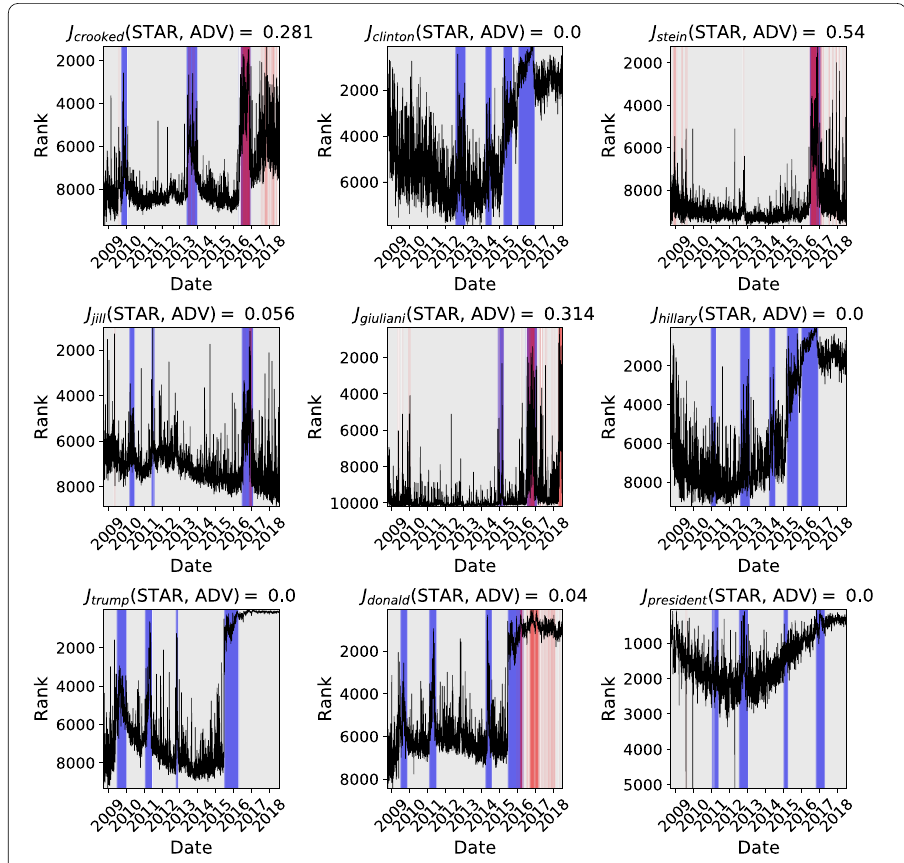
Figure 9 Comparison of STAR and Twitter’s Anomaly Detection Vector (ADV) algorithm used for detecting phenomena in Twitter 1gram time series. The Jaccard similarity coefficient is presented for each 1-gram and the region where events on detected are shaded for the respective algorithm. Blue-shaded windows correspond with STAR windows of shock-like behavior, while red-shaded windows correspond with ADV windows of anomalous behavior (and hence purple windows correspond to overlap between the two). In general, ADV is most effective at detecting brief spikes or strong shock-like signals, whereas STAR is more sensitive to longer-term shocks and shocks that occur in the presence of surrounding noisy or nonstationary dynamic. ADV does not treat strong periodic fluctuations as anomalous by design; though this may or